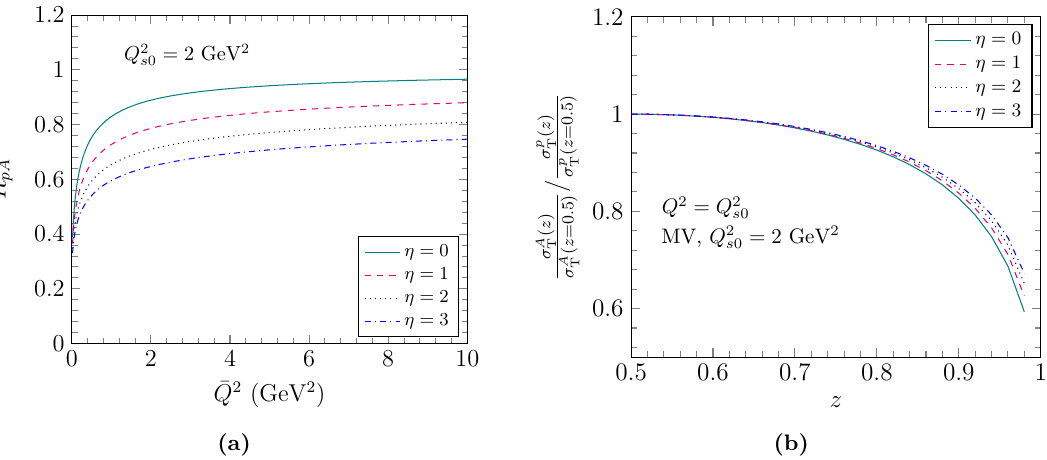
Figure 12. (a) The ratio R pA for the SIDIS cross-section integrated over k , as defined in eq. (4.12), and its rapidity evolution of up to η = 3 . The ratio is always smaller than 1 in contrast to the unintegrated case (cf. figure 7). (b) The nuclear modification factor for the normalised cross-section introduced in eq. (4.11) plotted as a function of z , for fixed Q 2 and for various values of η ≤ 3 . As z approaches 1 the ratio drops significantly below 1, due to the different z -dependences observed in figures 11a and 11b,